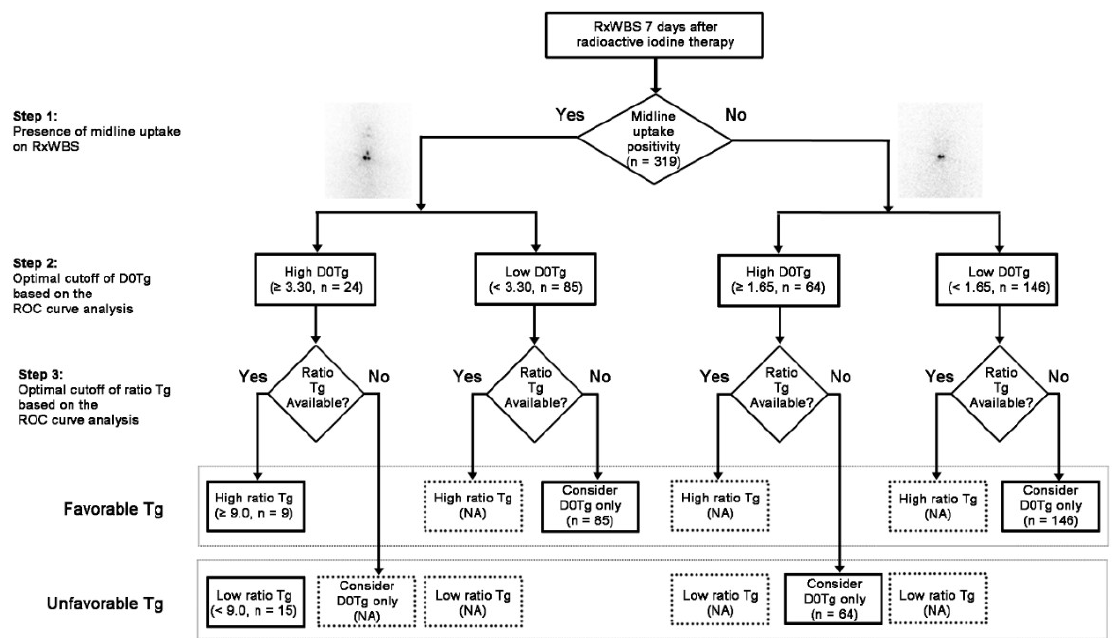
Figure 1. Diagnostic flow-chart based on the iodine scan-corrected thyroglobulin (Tg) for response prediction. Serum Tg and ratio Tg were optimized using the receiver operating characteristic curve analysis in each step. (RxWBS, post-therapeutic I-131 whole body scan; Tg, thyroglobulin; ratio Tg, serum thyroglobulin 7 days after the radioactive iodine therapy / serum thyroglobulin immediately before the radioactive iodine therapy; D7Tg, serum thyroglobulin 7 days after the radioactive iodine therapy; D0Tg, serum thyroglobulin immediately before the radioactive iodine therapy; NA, not applicable; ROC, receiver operating characteristic).